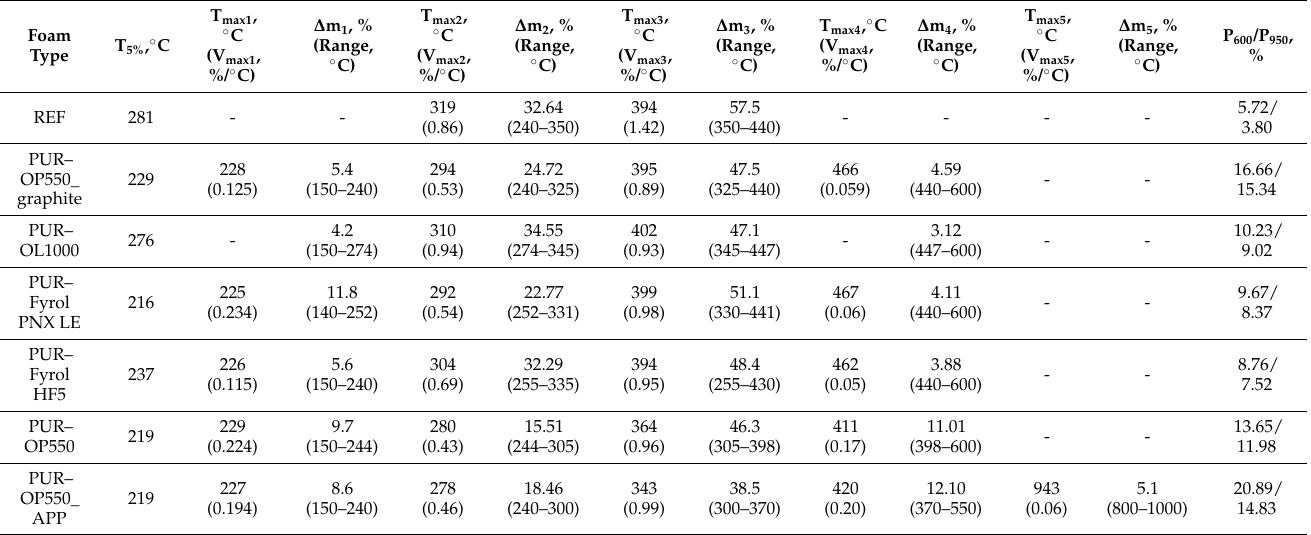
Figure 9. Summary of derivative weight change curves for the foams. Table 7. Foam parameters determined from thermogravimetric (TG) and derivative thermogravimet- ric (DTG)